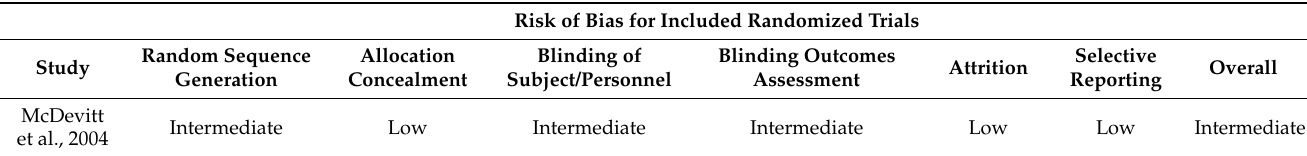
Table 2. Results of systematic quality appraisal for each randomized study using the cochrane collaboration tool for assessing risk of bias in randomized trials.